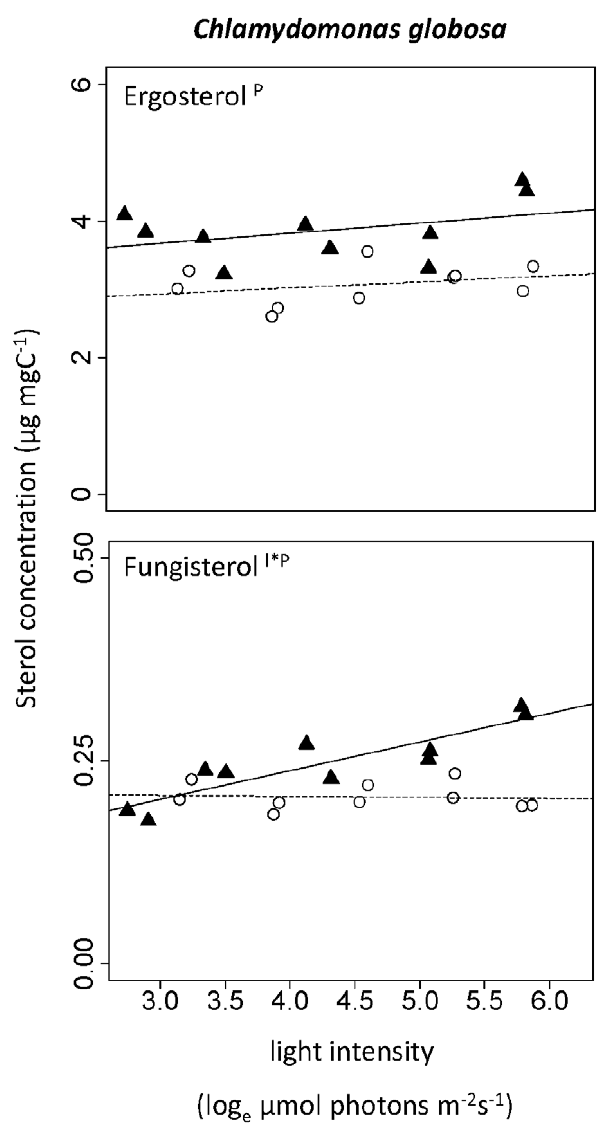
Figure 2. Change in sterol content with light intensity in Chlamydomonas globosa. ( m , straight line) High-P treatments. ( # , dashed line) Low-P treatments. Superscripts indicate statistically significant effects of light intensity (l), phosphorus supply (P), or interaction of these two factors (l*P). A regression line was added if one of the effects was significant.